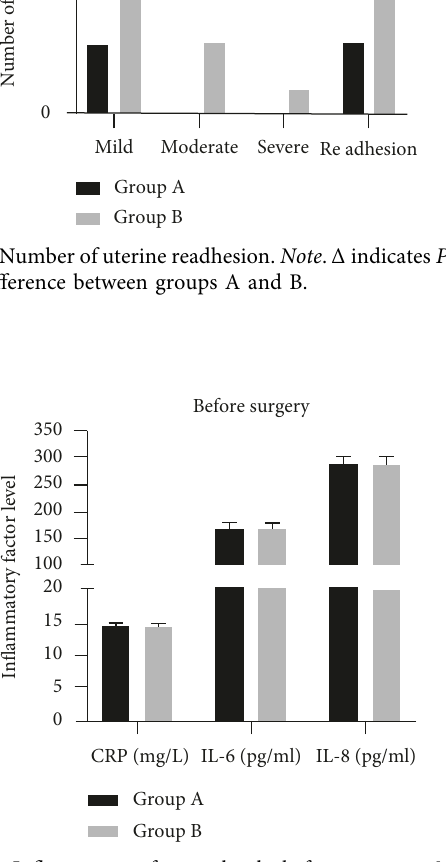
Figure 9: Inflammatory factors levels before surgery. Note . Δ indicates P < 0 . 005 for the difference between groups A and B.